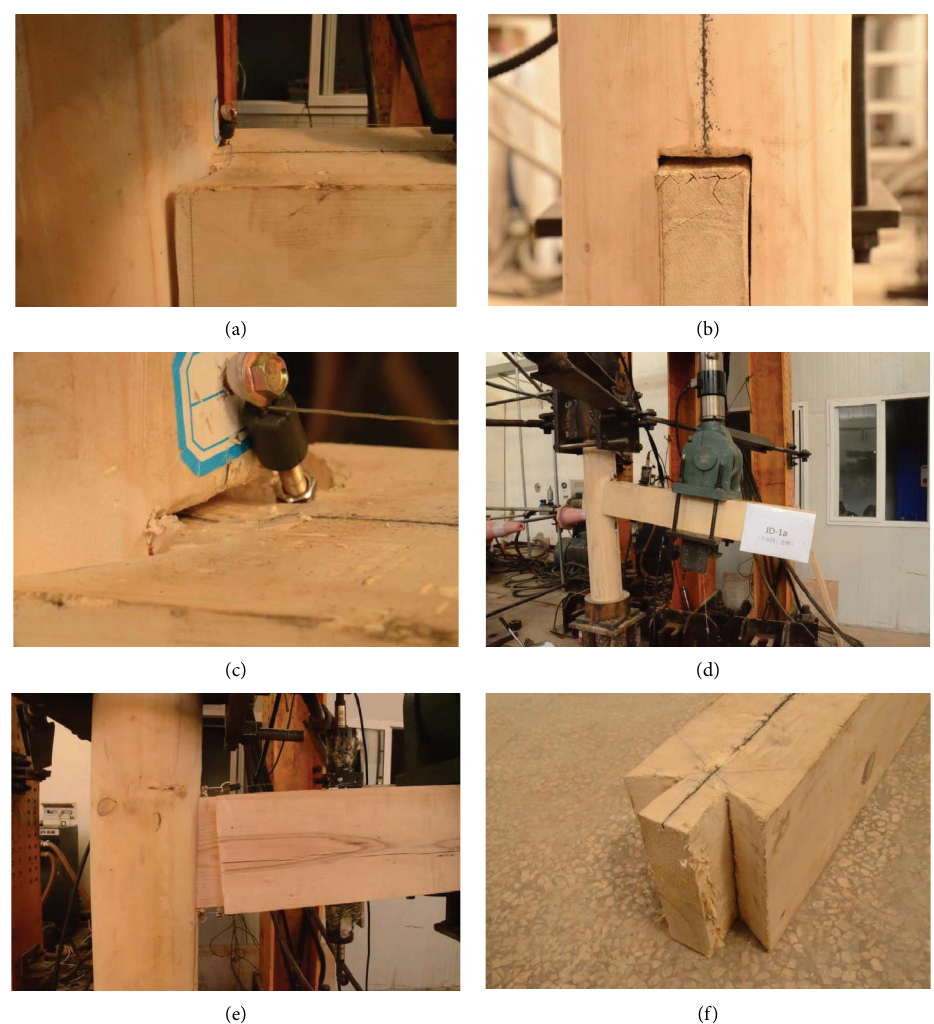
Figure 6: Damage pattern of unreinforced specimens: (a) squeezing of a mortise-tenon joint. (b) Crevice in a convex tenon. (c) Flawing after squeezing. (d) Overlarge deformation of JD-1a. (e) Overlarge pulling-out amount of JD-1b. (f) Deformation of the convex tenon of JD-1c.